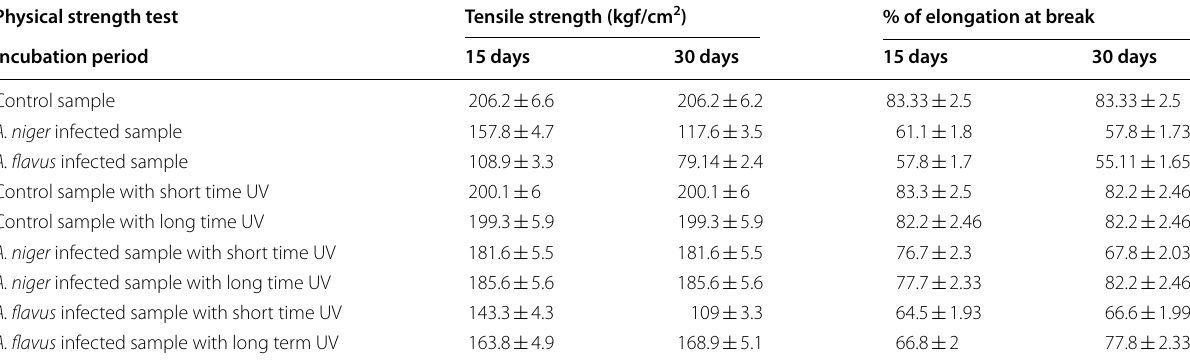
Table 1 Tensile strength and percentage of elongation at break of vegetable tanned leather sample Physical strength test